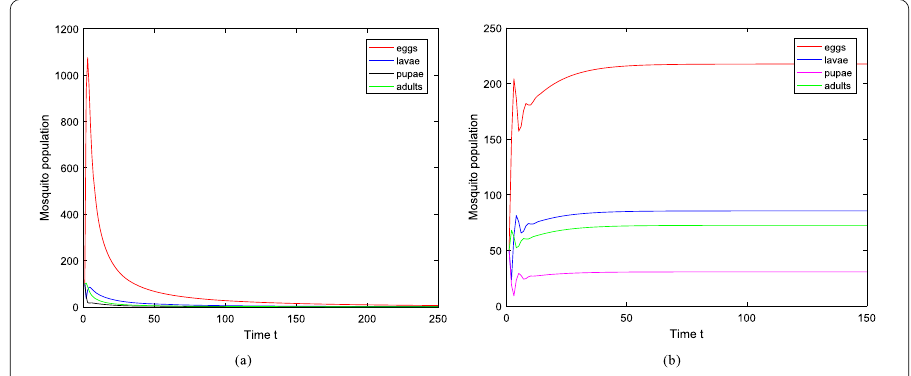
Figure 1 The red, blue, black, and green curves correspond to the eggs, larvae, pupae, adults classes, respectively. The survivorship functions are s i ( x ) = a i k i /( k i + a i x ), i = 1,2,4, with parameter values a 1 = 0.5, a 2 = 0.4, a 4 = 0.8, k 1 = 400, k 2 = 300, k 4 = 800, γ 1 = 0.3, γ 2 = 0.4, γ 3 = 0.5, and s 3 = 0.6. The initial conditions are given by E (0) = L (0) = P (0) = A (0) = 50. If b = 9, the inherent net reproductive number (cid:2) 0 = 0.9370 < 1, mosquito-free equilibrium E 0 is globally asymptotically stable. Solution approach E 0 as t → ∞ , shown in the left figure, where γ 1 = γ 2 = γ 3 = 1, with the same function forms and some parameters. As b = 3, the inherent net reproductive number (cid:2) 0 (1,1,1) = 1.8 > 1, E 1 = (30,70,82,210) is globally asymptotically stable. Solutions approach